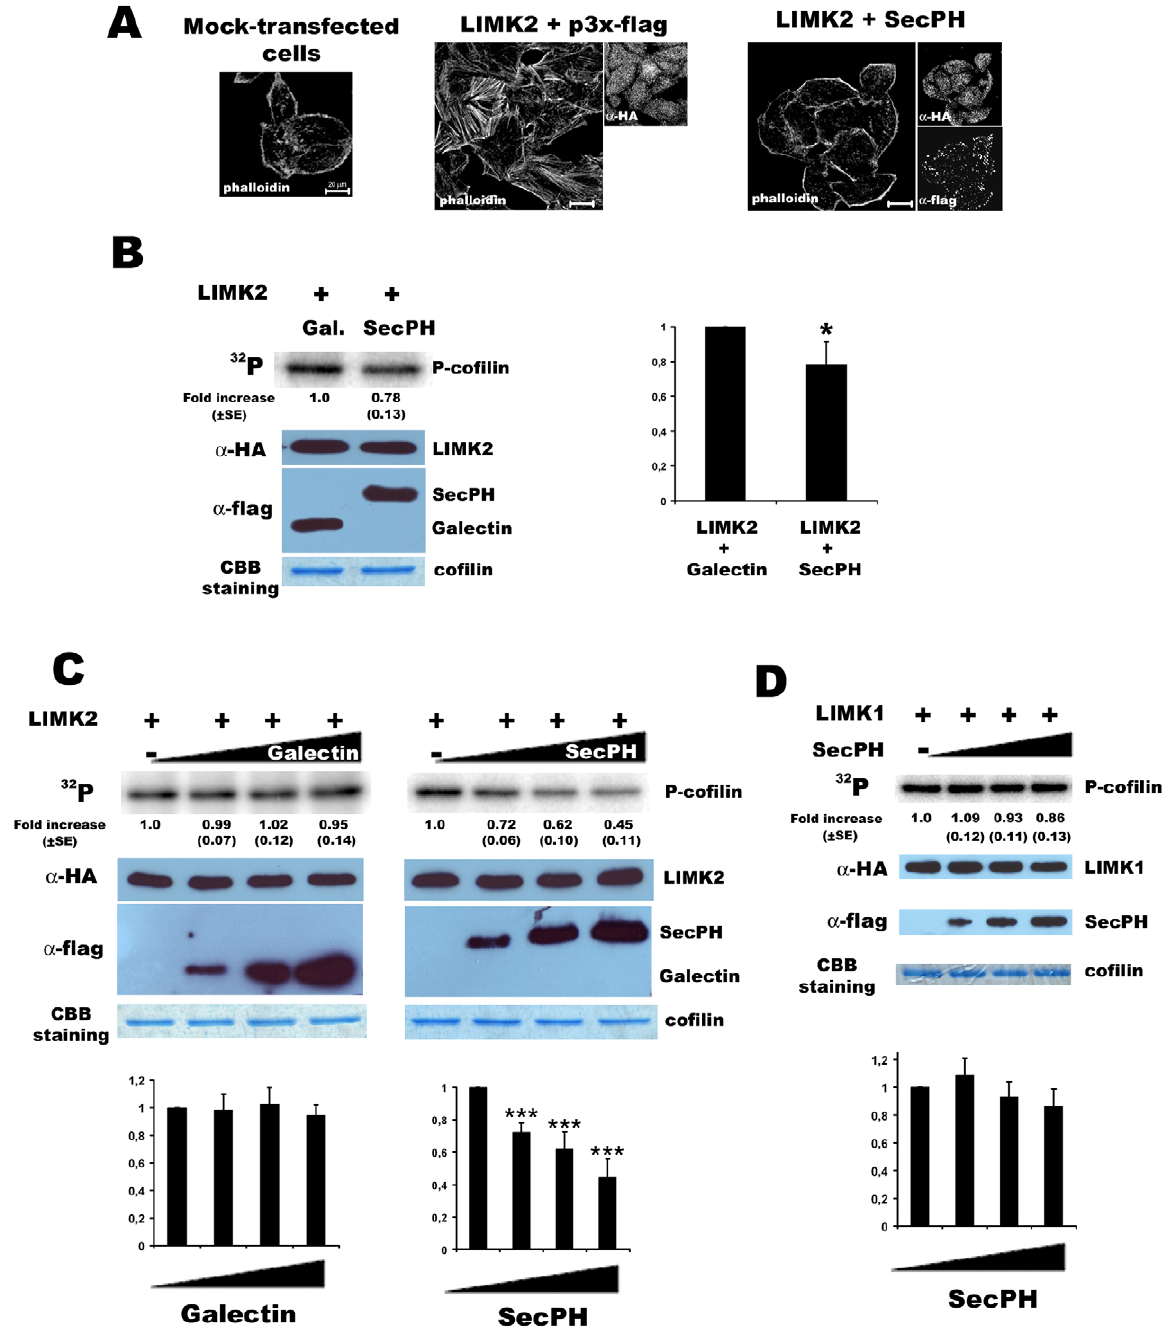
Figure 2. SecPH partially inhibits cofilin phosphorylation by LIMK2, but not by LIMK1. A . Actin cytoskeleton organisation . HeLa cells were cotransfected with pcDNA3, LIMK2 and SecPH or its parental empty plasmid, p3XFlag. Cells were fixed and stained with phalloidin, or anti-HA or anti- flag antibodies. B. Inhibition of LIMK2 cofilin phosphorylation by SecPH. Cells were cotransfected with LIMK2 and SecPH or Galectin-3 (a non-specific control protein). Immunoprecipitated HA-LIMK2 and GST-cofilin were used in the kinase assay. The kinase activity on cofilin of immunoprecipitated HA-LIMK2 from cells cotransfected with Galectin-3 was taken as 1.0. Each value represents the mean 6 SE (standard error) of four independent experiments. Statistical significance was determined relative to control using one-way ANOVA (* p , 0.05). The HA-immunoprecipitates were also submitted to HA-immunoblotting and to coomassie blue staining. Lysates were submitted to flag-immunoblotting. C. Dose dependent inhibition of LIMK2 cofilin phosphorylation by SecPH. Cells were transfected with LIMK2 and either SecPH or Galectin-3. SecPH and Galectin-3 cell lysates were immunoprecipitated with anti-flag beads, beads were then eluted flag peptide. Immunoprecipitated HA-LIMK2 and GST-cofilin were used for kinase assay and were incubated with increasing amount of immunoprecipitated SecPH or Galectin-3 (0, 6, 12, 18 ul respectively). The kinase activity on cofilin of immunoprecipitated HA-LIMK2 with no addition of immunoprecipitated SecPH or Galectin-3 was taken as 1.0. Each value represents the mean 6 SE of four independent experiments. Statistical significance was determined relative to control using one-way ANOVA (*** p , 0.0001). Immunoprecipitates were also subjected to immunoblotting and to coomassie blue staining. D. SecPH does not inhibit cofilin phosphorylation by LIMK1. Cells were transfected either with SecPH or with LIMK1. SecPH cell lysates were immunoprecipitated with anti-flag beads, beads were then